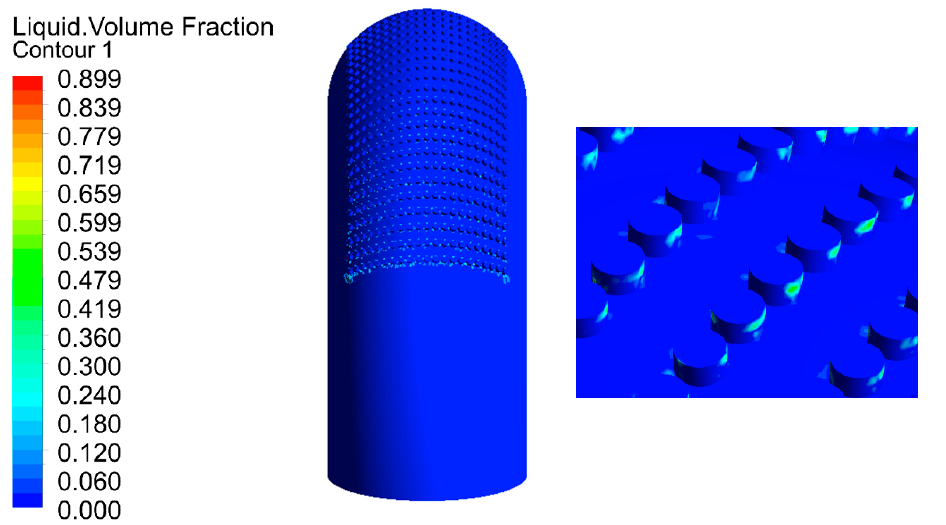
Figure 20. Distribution of the liquid volume fraction.